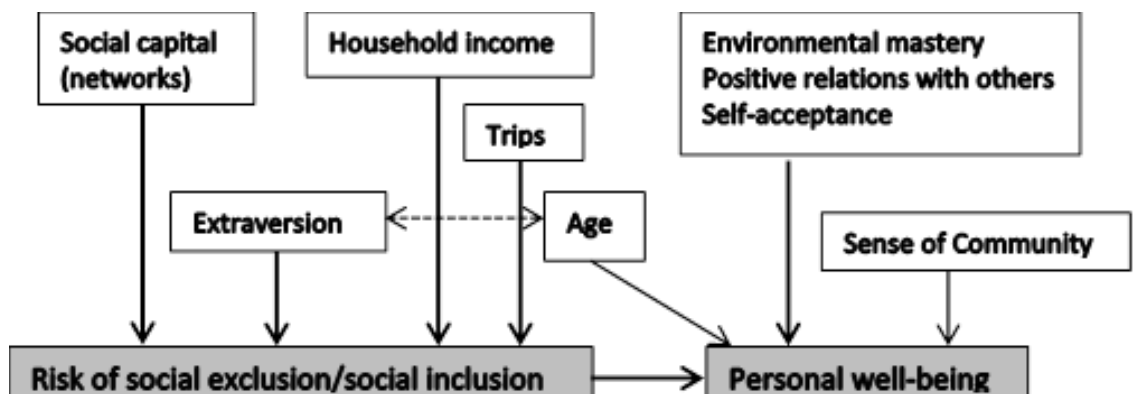
Figure 1. Mobility, social exclusion and well-being: hypothesized relationships (based on Stanley et al.,